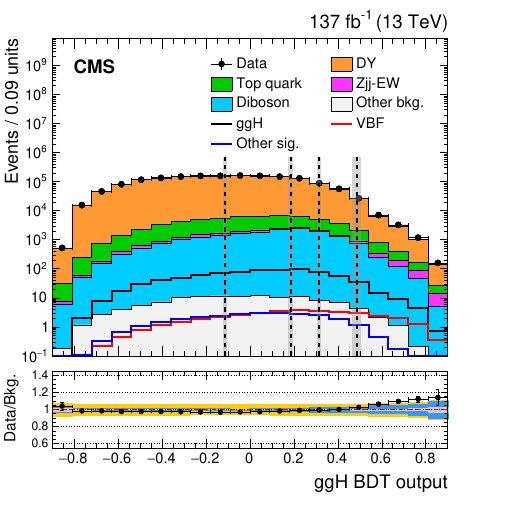
Figure 4 . Left: the observed BDT output distribution compared to the prediction from the simu- lation of various SM background processes. Dimuon events passing the event selection requirements of the ggH category, with m between 110–150 GeV, are considered. The expected distributions µµ for ggH , VBF, and other signal processes are overlaid. The grey vertical bands indicate the range between the minimum and maximum BDT output values used to define the boundaries for the opti- mized event categories for different data-taking periods. In the lower panel, the ratio between data and the expected background is shown. The grey band indicates the uncertainty due to the limited size of the simulated samples. The azure band corresponds to the sum in quadrature between the statistical and experimental systematic uncertainties, while the orange band additionally includes the theoretical uncertainties affecting the background prediction. Right: the signal shape model for the simulated H → µ + µ − sample with m = 125 GeV in the best (red) and the worst (blue) H resolution